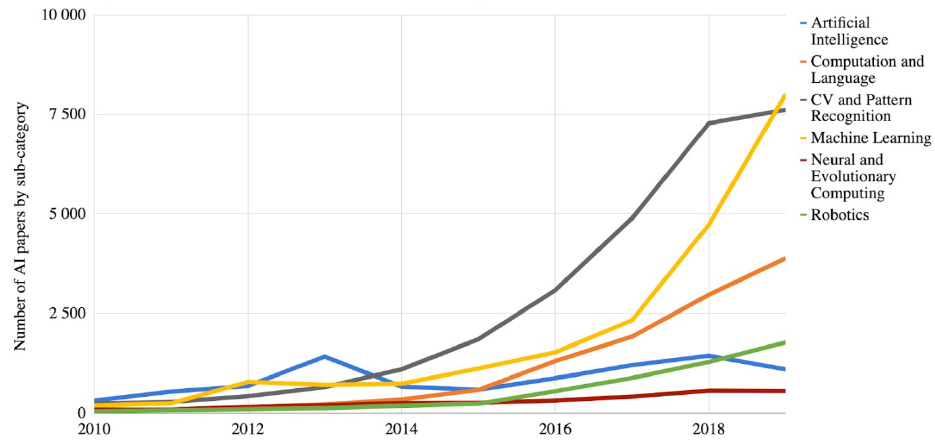
Figure 2. Number of AI papers on arXiv, 2010–2019 [22].